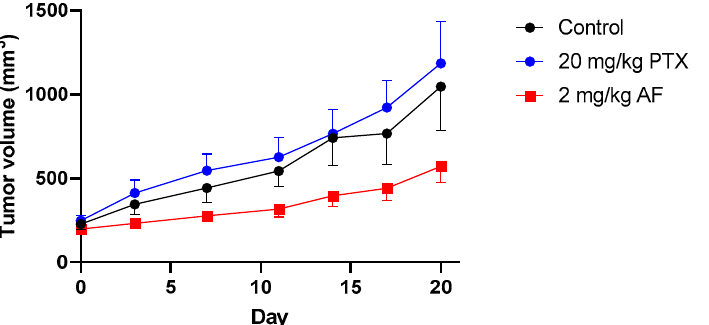
Figure 4. Antitumor efficacy of taccalonolide AF against the NCI/ADR-RES flank xenograft model. Animals were dosed on days 0 and 4 with 20 mg/kg PTX, or 2 mg/kg AF on days 0, 4, and 7 via i.p. injection as compared to untreated control tumors. Control (n = 9), PTX (n = 7), taccalonolide AF (n = 9). Comparison of each of the treatments with control and with each other by two-way ANOVA showed a statistically significant treatment * day interaction for taccalonolide AF vs. control (F (6, 96) = 2.68, p = 0.019) and for taccalonolide AF vs. paclitaxel (F (6, 84) = 5.67, p < 0.0001), but not for paclitaxel vs. control (F (6, 84) = 0.1913, p = 0.98).